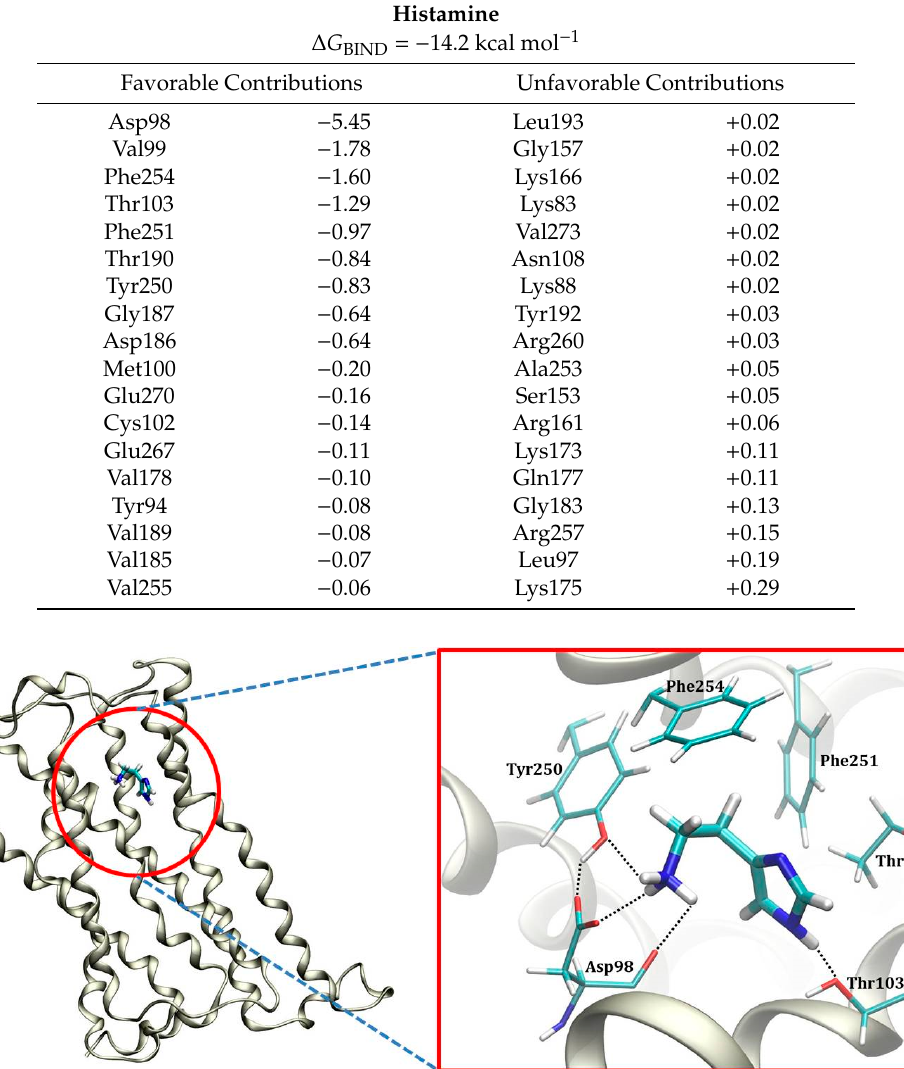
Table 1. MM-GBSA binding free energy ( ∆ G BIND ) from the molecular dynamics trajectory and its decomposition on a per-residue basis (in kcal mol − 1 ). Residues are selected to list all of those with favorable contributions over –0.06 kcal mol − 1 and unfavorable contributions over + 0.02 kcal mol − 1 .